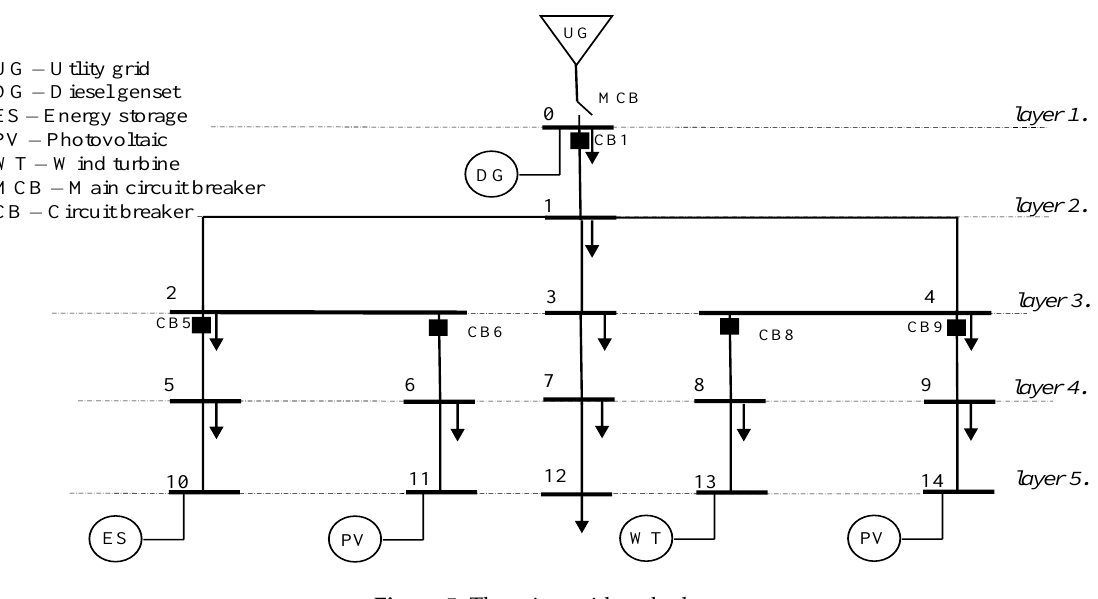
Figure 5. The microgrid testbed.